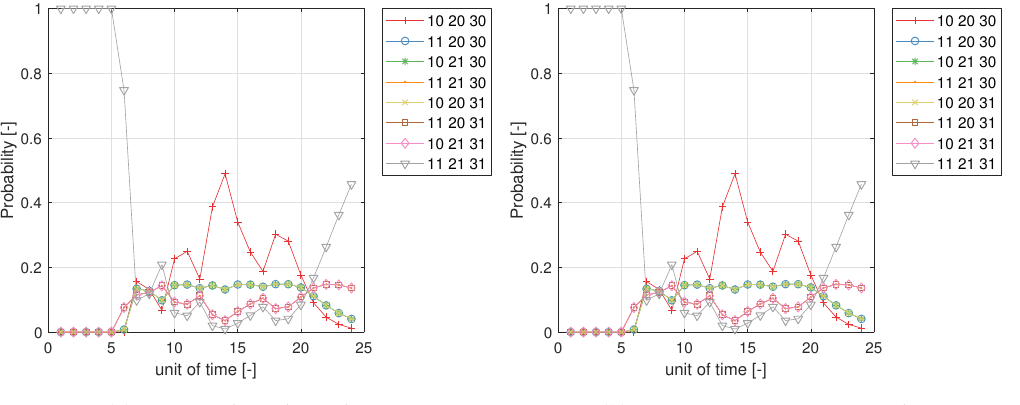
Figure 4. Network State Probability: Two critical lines with wind speed profile ‘A’.